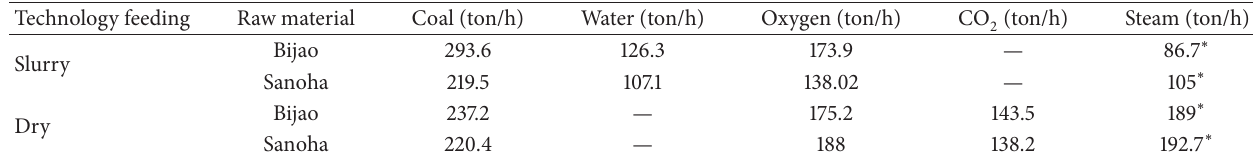
Table 3: Mass flow rates used in the model as inlet streams. Technology feeding